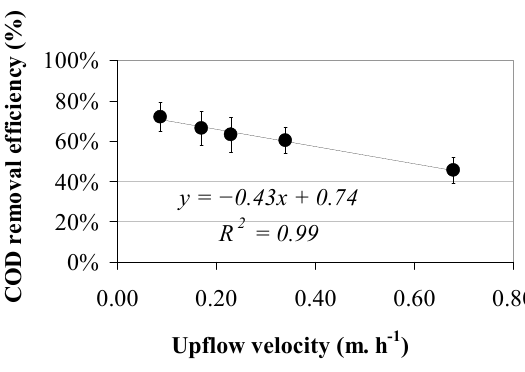
Figure 3. Total COD removal efficiencies in two UASB reactors, characterized by a sludge bed height between 0.30 and 0.40